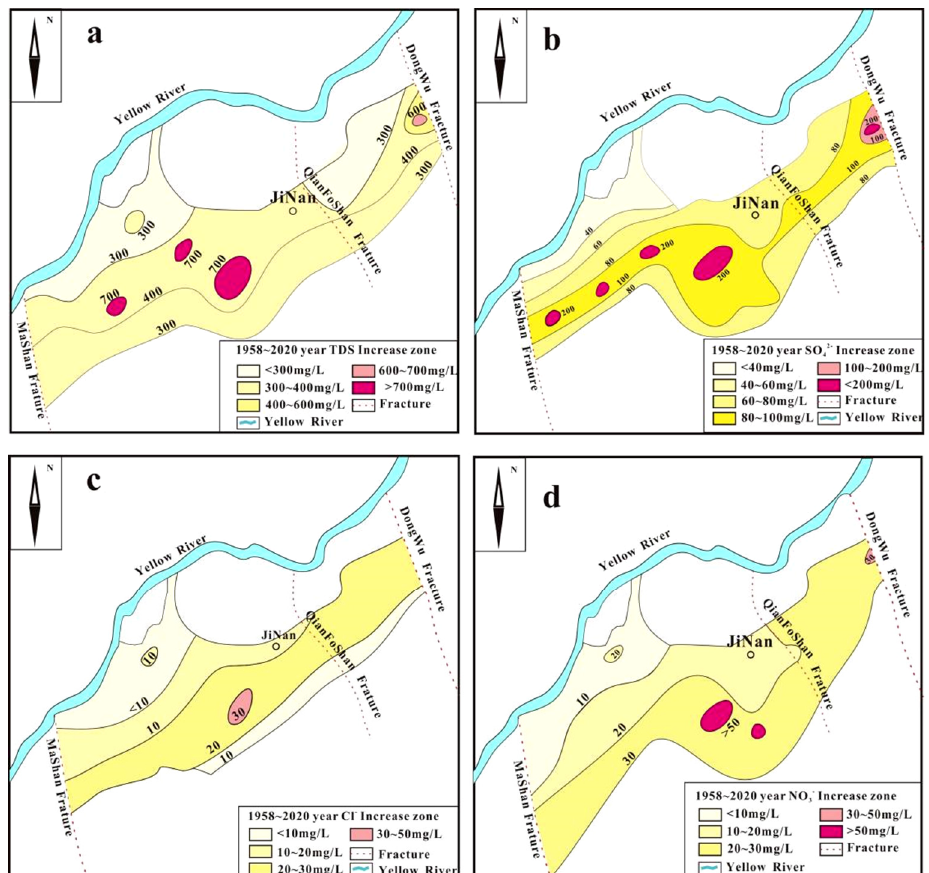
Figure 11. Elevation of major parameters (( a ) TDS; ( b ) SO 42 − ; ( c ) Cl − , ( d ) NO 3 − ) in karst water during 1958–2020.